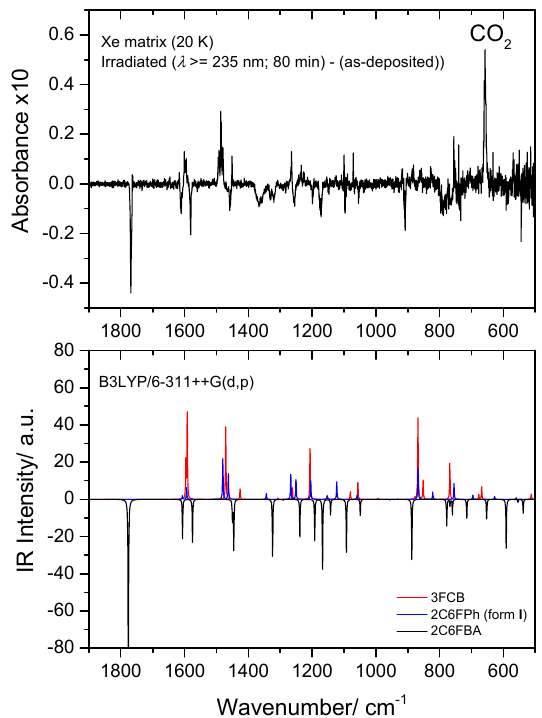
Figure 16. Top : Low frequency region of the difference IR spectrum: irradiated Xe matrix of 2-chloro- 6-fluorobenzoic acid (2C6FBA) minus as-deposited matrix. Bottom: Simulated difference spectrum based on the B3LYP/6-311++G(d,p) calculated IR spectra of 2C6FBA ( cis conformer; bands pointing down) and the observed photoproducts: CO 2 , 2-chloro-6-fluorophenol (2C6FPh) and 3-fluoro- chlorobenzene (3FCB) (bands pointing up). The calculated wavenumbers were scaled by 0.978, and the calculated intensities of the reactant and of the different photoproducts were multiplied by arbitrary factors in order to fit better the observed spectrum (in a ratio of ~3:2:1, 2C6FBA:3FCB:2C6FPh).